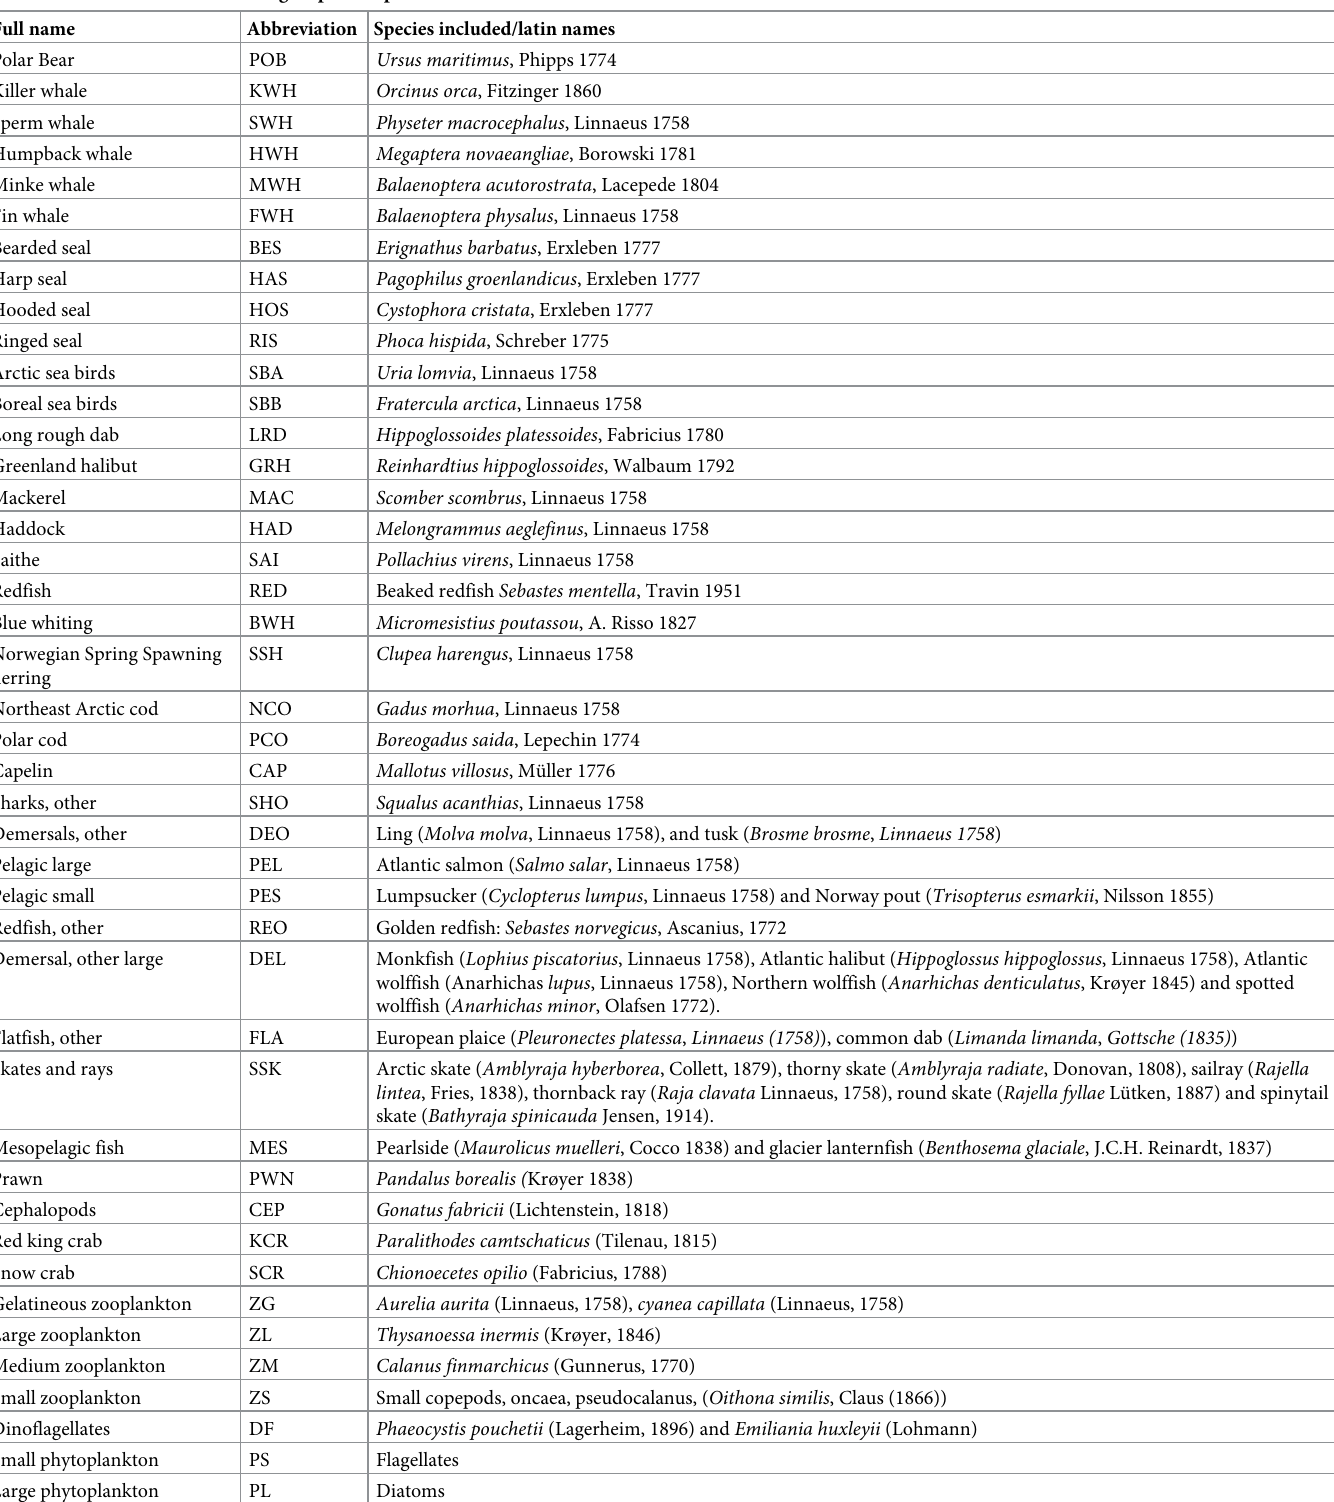
Table 1. Overview over functional groups and species included in NoBa Atlantis. Full